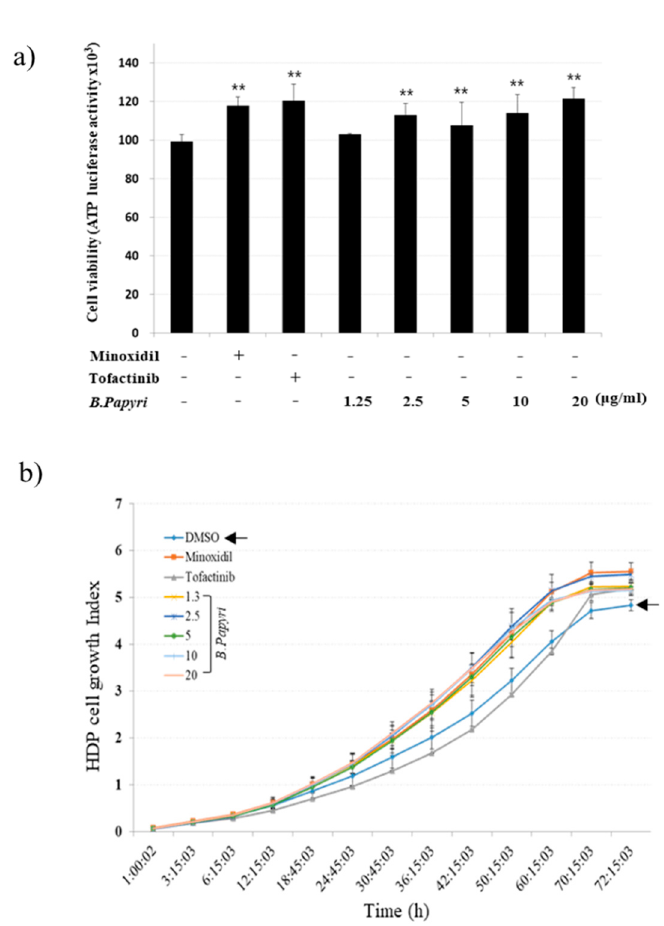
Figure 1. Effects of B. papyrifera on hHFDP cells. ( a ) CellTiter ‐ Glo® luminescent cell growth assay shows that B. papyrifera promote proliferation of hHFDP cells; ( b ) Real-time xCELLigence system as described in the Methods. All experiments were performed in triplicate. The asterisk indicates a significant statistical significance (** p < 0.05).